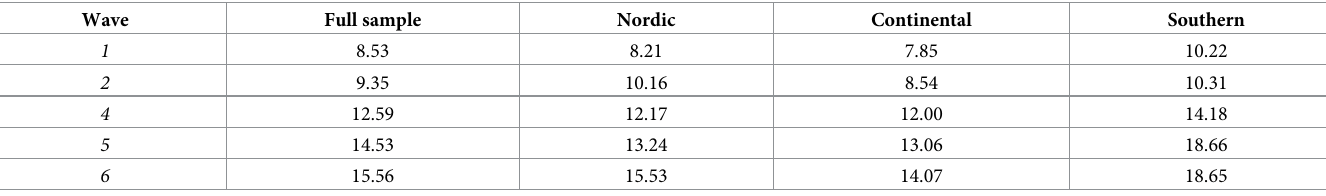
Table 2. Distribution (percentages) of Chronic in the analytical sample by SHARE Wave and geographic macro-area (all countries (9); sample size (n) = 37,864).